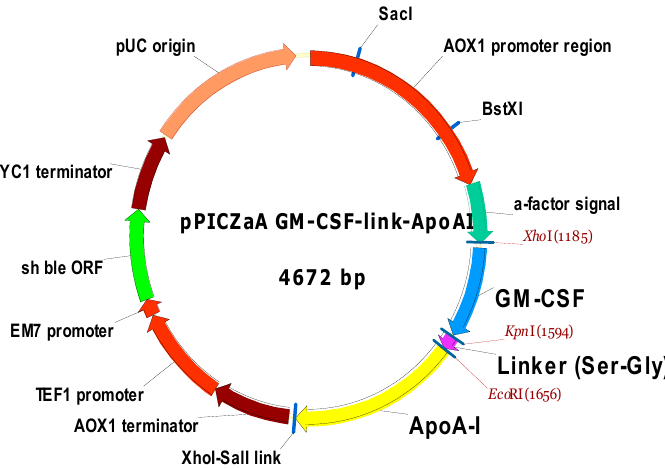
Figure 1. Construction of the pPICZ α A/ryGM-CSF-link-ApoA-I recombinant plasmid.